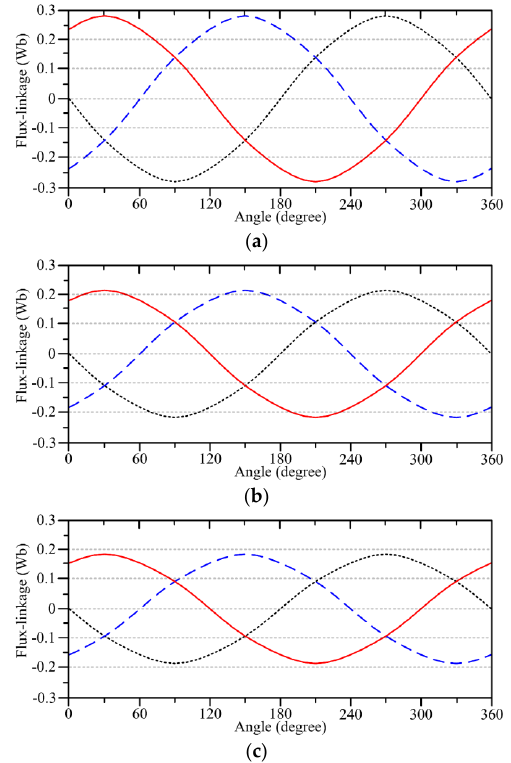
Figure 6. Flux-linkages (Red: phase-A, blue: phase-B and black: phase-C): ( a ) PS-SFPM; ( b ) FA-PS- SFPM; ( c ) PS-SFDE.